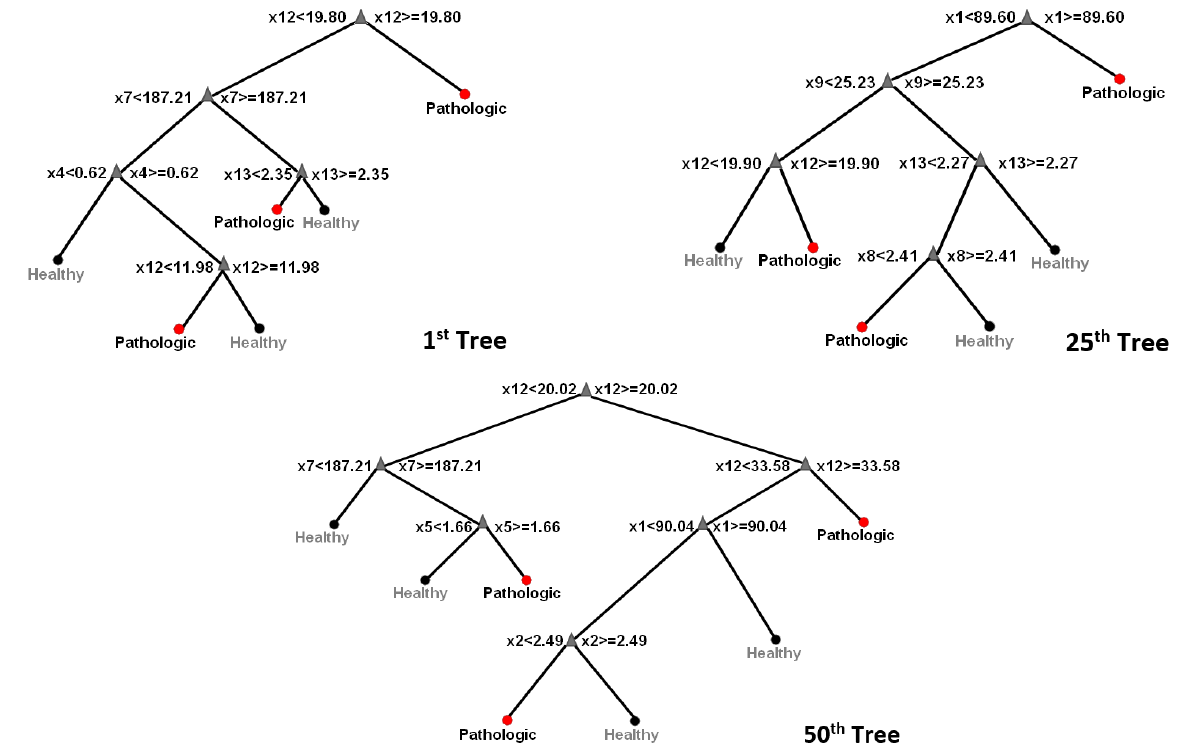
Figure 3. Random forest tree visualization. Ensemble classifiers from the aggregation of multiple decision trees.